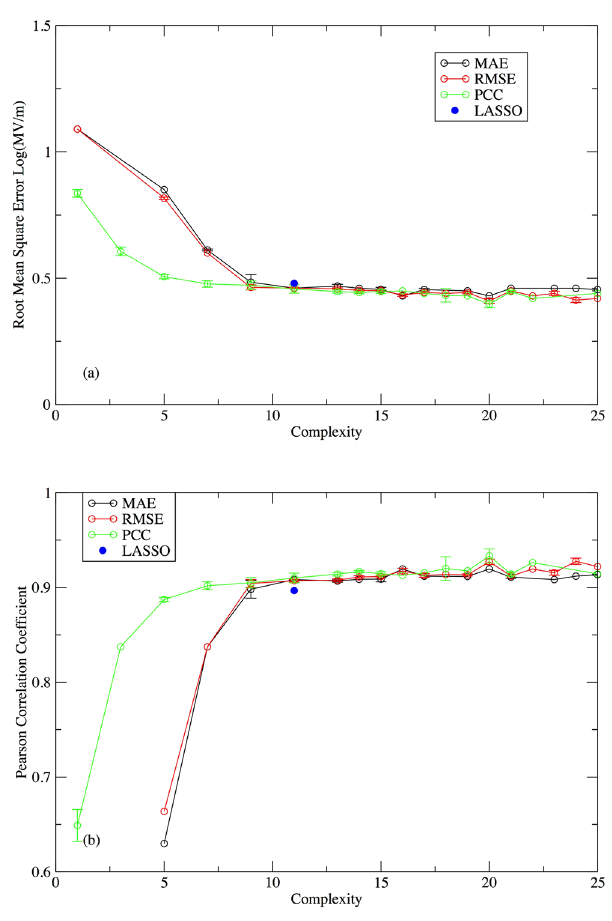
Figure 3. Average ( a ) RMSE and ( b ) PCC performance of models on total input data (training plus validation datasets) by MAE, RMSE, PCC optimizations compared with the LASSO solution. The error bar is the calculated standard deviation from averaging over 16 parallel Eureqa